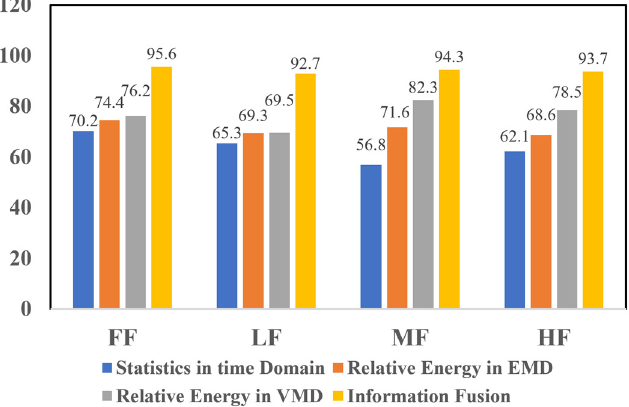
Figure 6. The accuracy of four kinds of SVM classifiers.